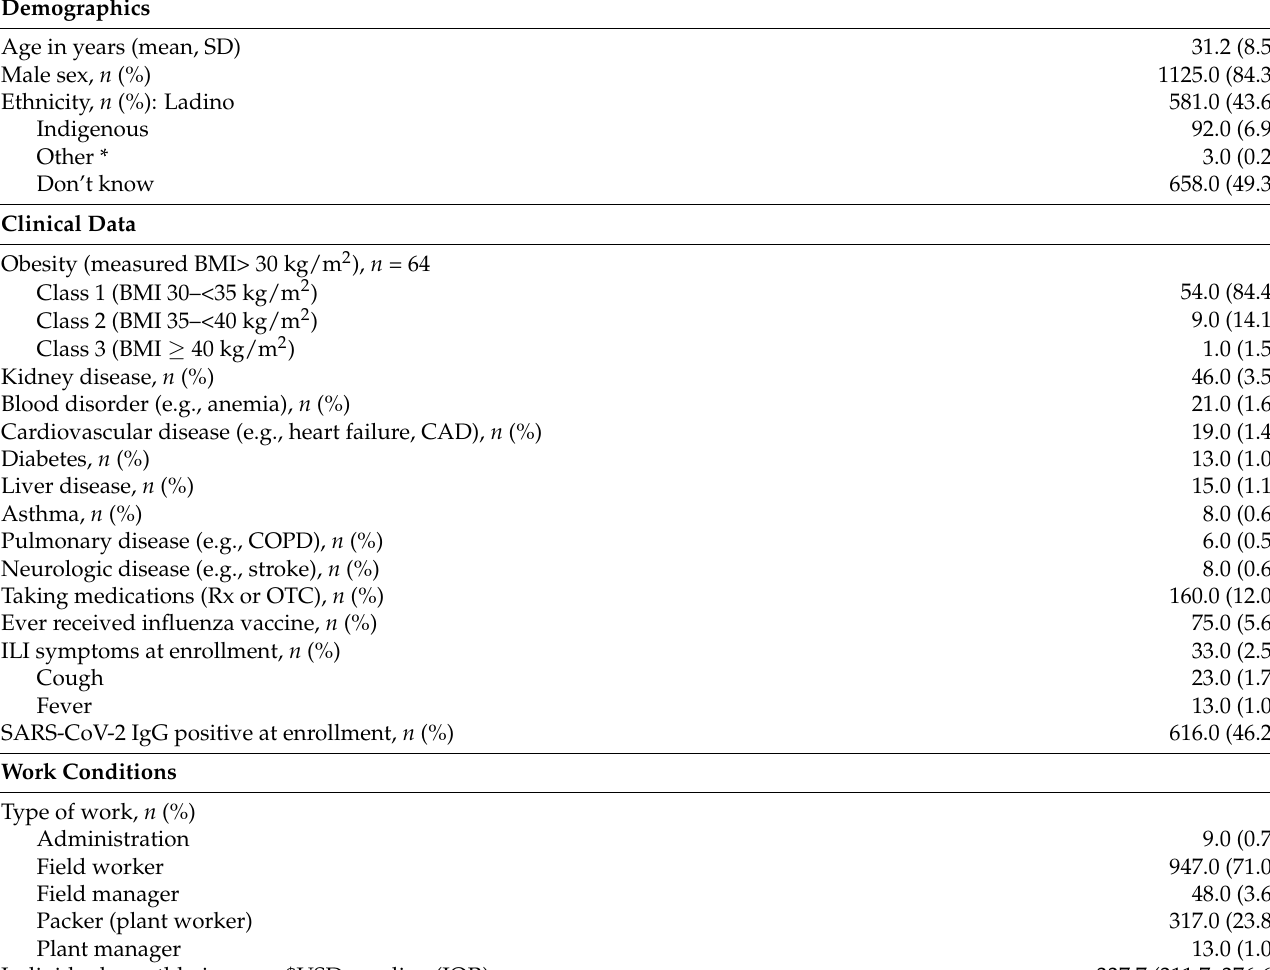
Table 1. Sociodemographic, clinical, and economic characteristics of cohort participants with baseline SARS-CoV-2 serology, Guatemala ( n =